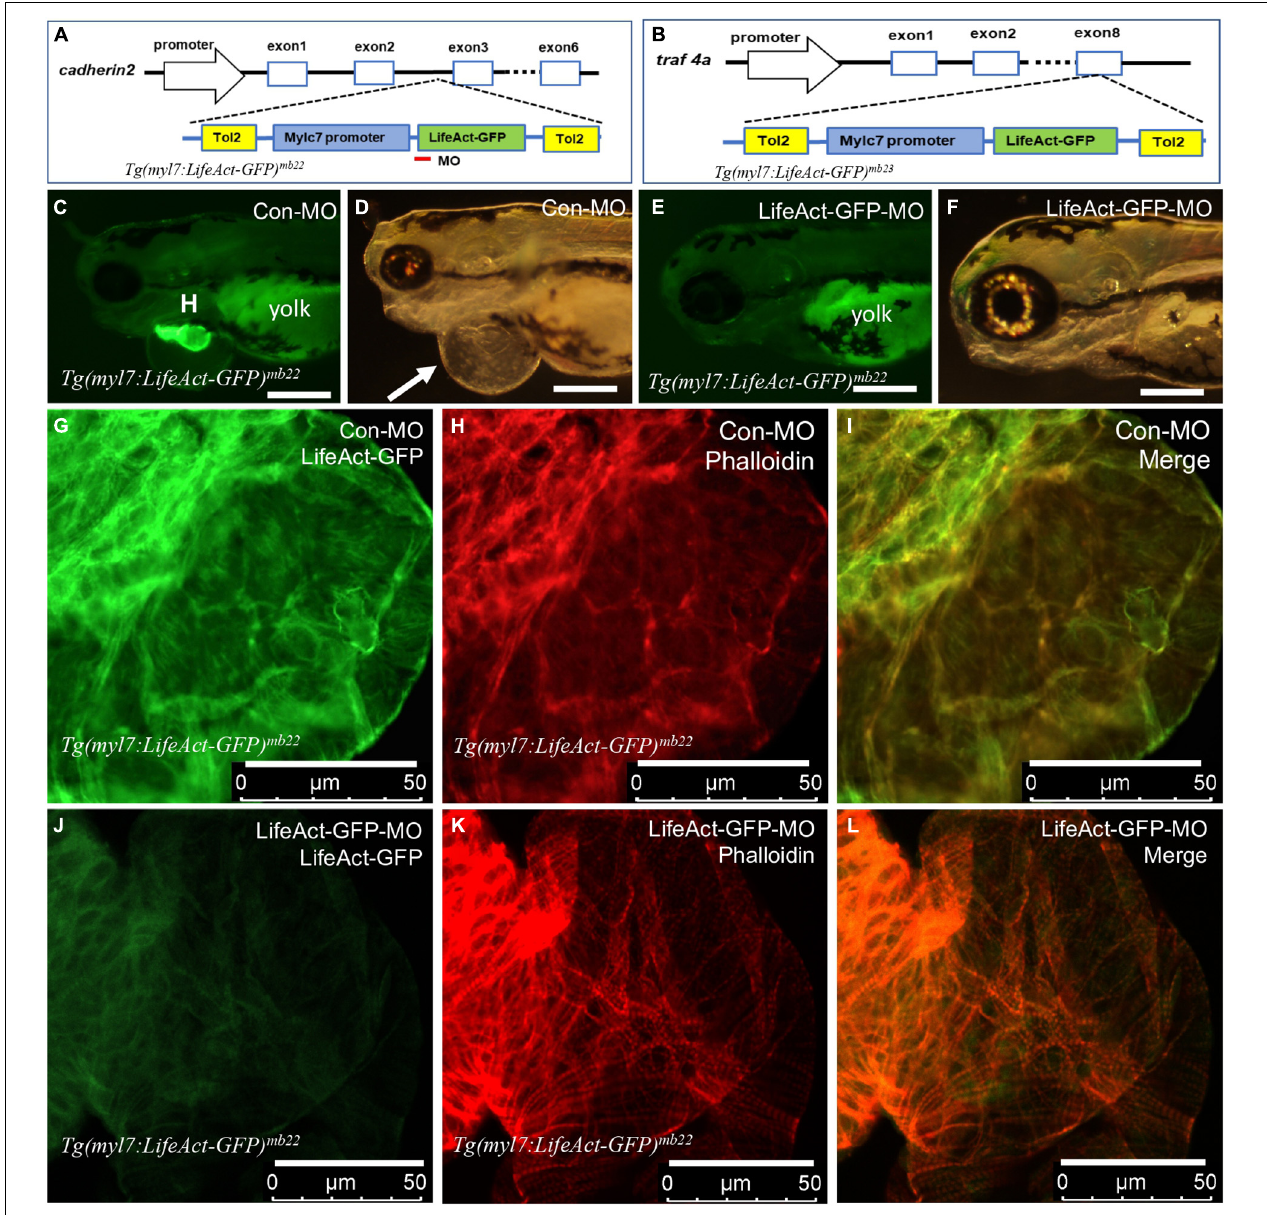
FIGURE 4 | Identification of transgene integration sites in Tg(myl7:Lifeact-GFP) mb 22 and Tg(myl7:Lifeact-GFP) mb 23 transgenic embryos and the rescue of heart defect by knockdown of Lifeact-GFP expression. (A,B) Mapping the transgene integration sites in Tg(myl7:Lifeact-GFP) mb 22 and Tg(myl7:Lifeact-GFP) mb 23 transgenic embryos at cadherin2 and traf4a genes, respectively. The Lifeact-GFP-MO is indicated by the red line. (C–F) Morphology of heart region of Tg(myl7:Lifeact-GFP) mb 22 transgenic embryos at 72 hpf injected with control-MO (C,D) and Lifeact-GFP-MO (E,F) , respectively. Pericardial edema is indicated by the arrow in control-MO injected Tg(myl7:Lifeact-GFP) mb 22 (D) transgenic mutant larvae. H, heart; Yolk shows autofluorescence. Scale bars: 250 µ m. (G–L) Lifeact-GFP expression (G,J) and phalloidin staining (H,K) showing actin think filaments in cardiomyocytes of Tg(myl7:Lifeact-GFP) mb 22 transgenic embryos